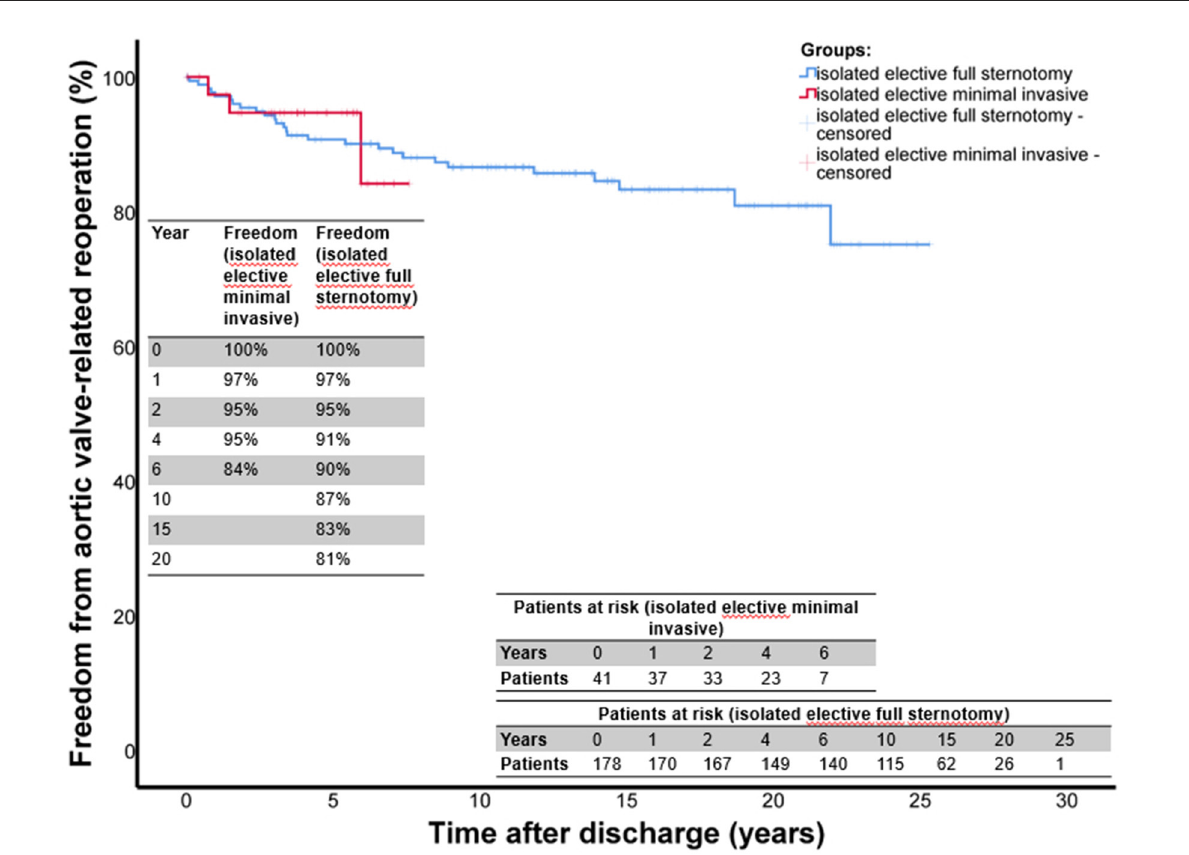
FIGURE2 Freedom from aortic valve-related reoperation after isolated elective AVSRR. This figure shows the Kaplan Meier curves for freedom from aortic valve-related reoperation after isolated, elective David-I procedure. The red curve shows the mini access patients (group A) and the blue curve shows the full sternotomy patients (group B). Time origin on x-axis denotes day of